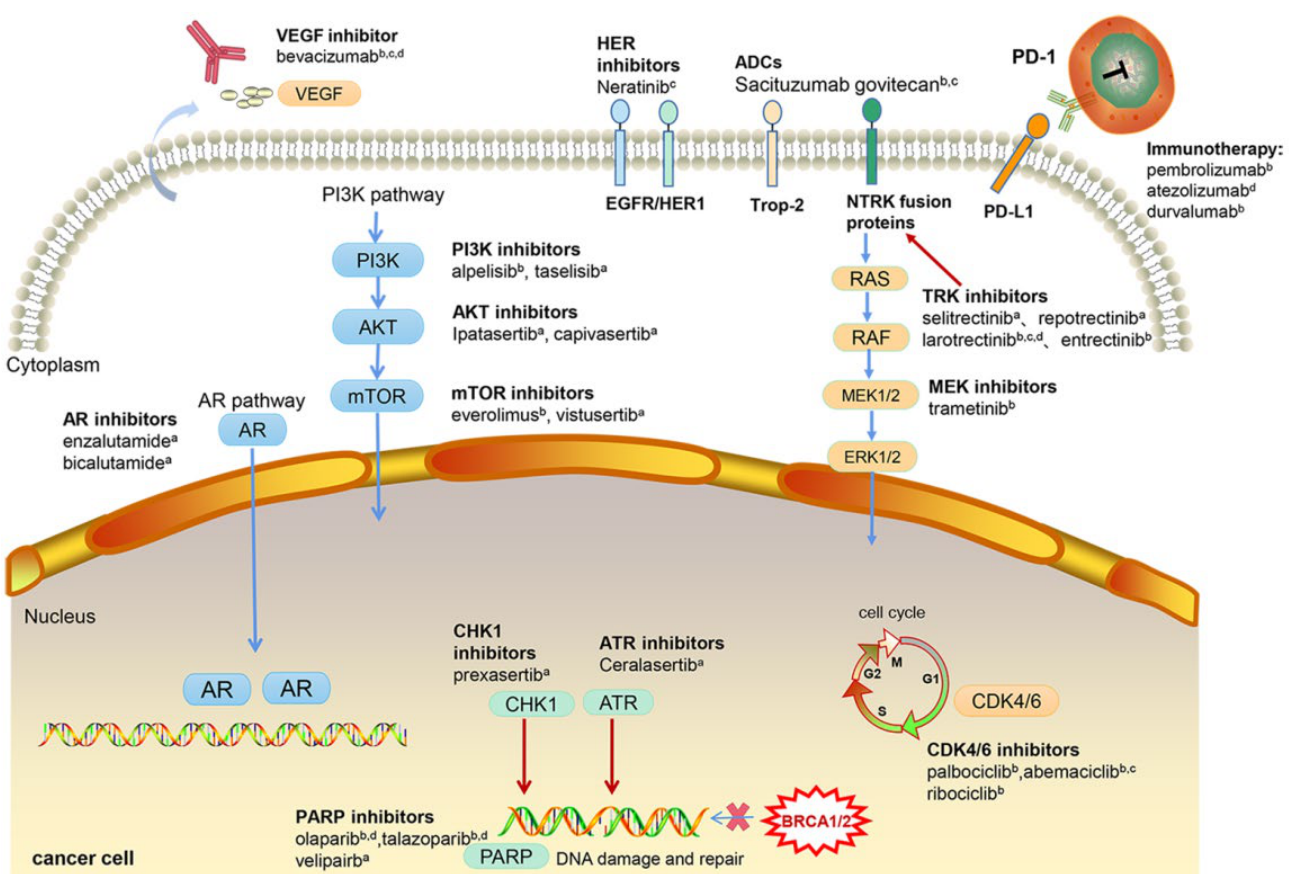
Figure 1. The mechanism of novel therapeutic drugs in mTNBC clinical studies. ADCs: antibody– drug conjugates; AR: androgen receptor; PARP: poly (ADP-ribose) polymerase; Trop-2: trophoblast cell-surface antigen 2; PD-1: programmed cell death-1; PD-L1: programmed cell death-ligand 1; VEGF: vascular endothelial growth factor; CHK: checkpoint kinase; CDK: cyclin-dependent ki- nase; ATR: ataxia telangiectasia and Rad3-related kinase; PI3K: phosphatidylinositol 3-kinase; MEK: mitogen-activated extracellular signal-regulated kinase; EGFR: epidermal growth factor; HER: human epidermal growth factor receptor. (a) In clinical trial; (b) Registered by Food and Drug Administration; (c) Registered by National Medical Products Administration; (d) Registered by European Medicines Agency.